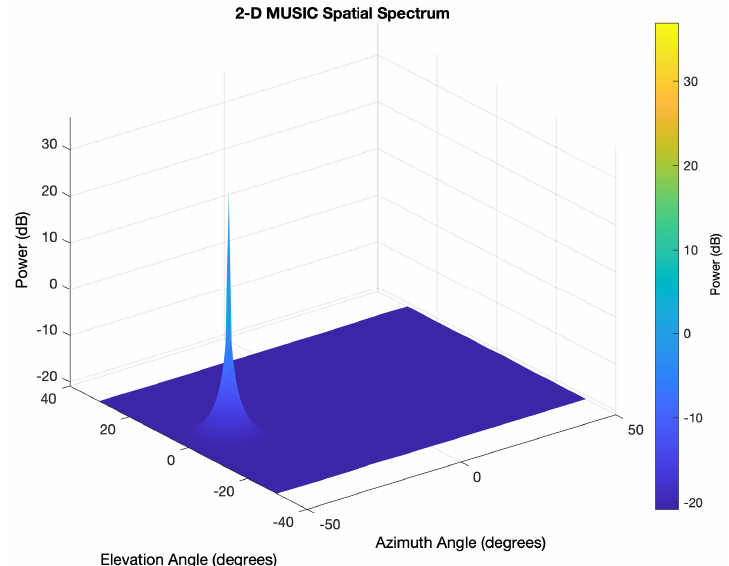
Figure 8. The MUSIC method practices IQ samples to generate a pseudo power spectrum, in which the tip identifies the location of the broadcasting device. The graph depicted in this Figure exhibits a 2D pseudo spectrum, in which the transmitting device is at an azimuth angle of − 37 degrees and an elevation angle of 0